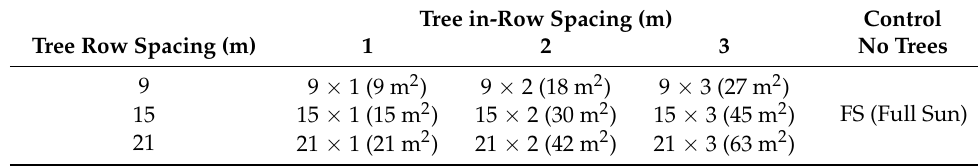
Table 6. The treatments of the alley cropping experiment, which are actually the different growing spacings of black locust stands. In brackets, the growing spacings are shown for each tree. Tree in-Row Spacing (m)